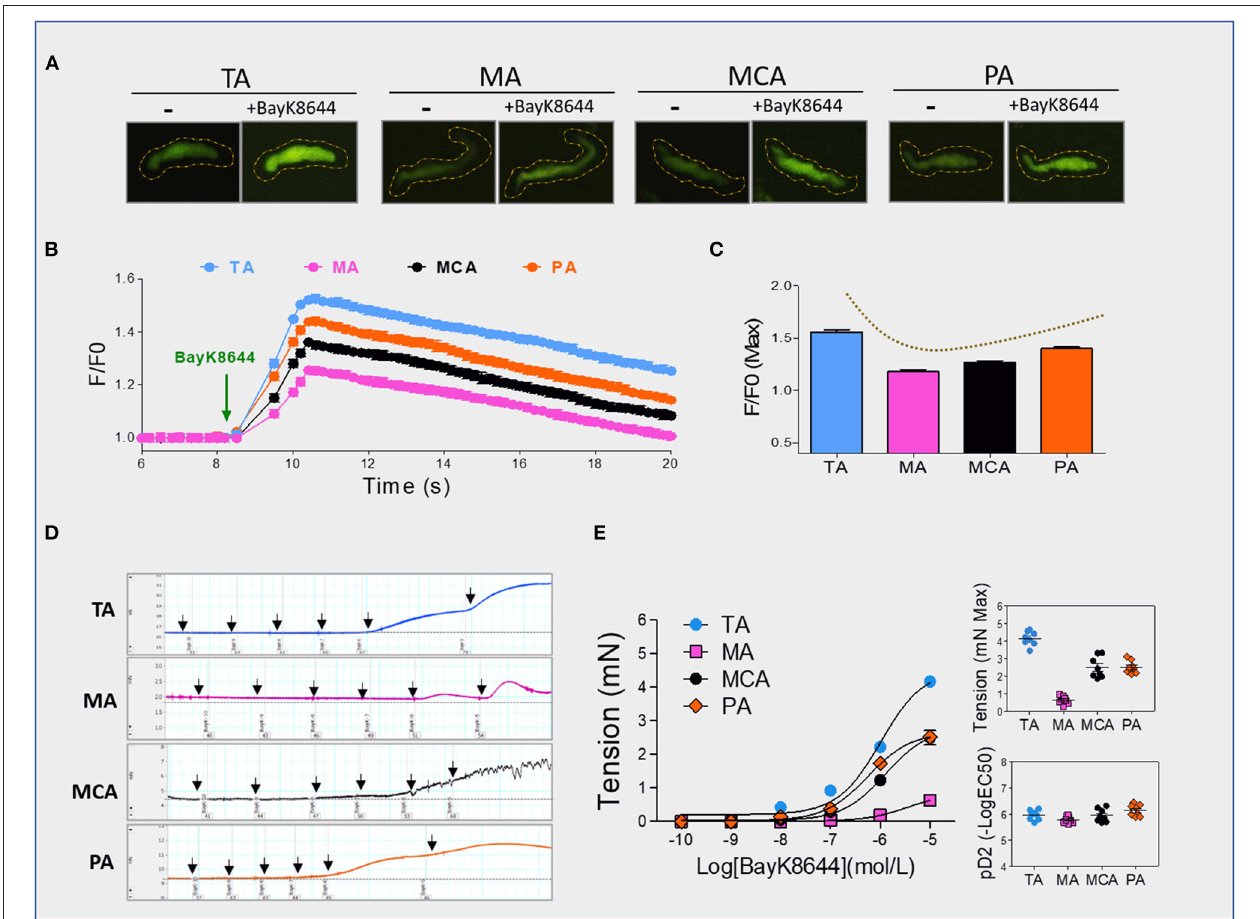
FIGURE 2 | BayK8644-induced vasoconstrictions and [Ca 2 + ]i signals. (A–C) BayK8644-induced Ca 2 + increases in single isolated vascular SMC from TA, MA, MCA, or PA. Representative traces (A) and statistics (B) of Ca 2 + transients elicited by BayK8644 (10 − 5 mol/L) measured with the fluorescence Ca 2 + indicator Fluo-3 AM. Maximum of Ca 2 + responses (C) were calculated. The fractional fluorescence intensity was calculated as F/F0, where F is the fluorescence intensity for the region of interest, and F0 is the fluorescence intensity during a period from the beginning of the recording when there was no Ca 2 + activity (n = 30 cells from ten rat per group), (D) Representative tracings of BayK8644-induced vasoconstrictions in TA, MA, MCA, or PA rings, (E) Statistics of BayK8644-induced vasoconstrictions and pD2 in vessel rings ( N = 4, n = 8). N, number of adult male offspring; n, number of vessel rings. pD2, –log[50% effective concentration]. Data were presented as means ±